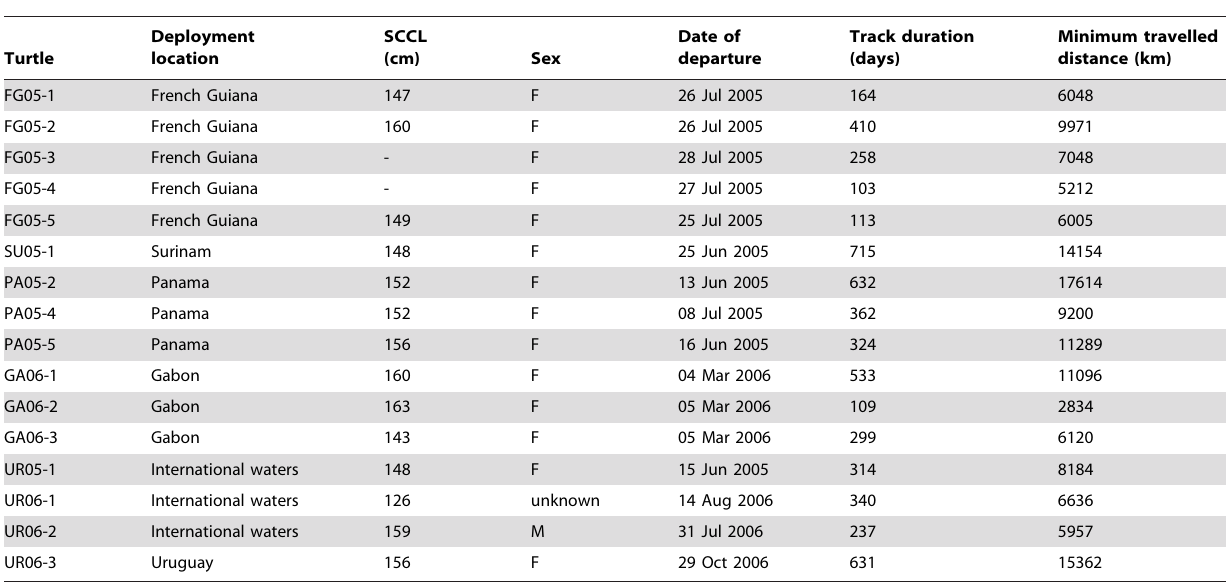
Table 1. Summary of the movements of 16 Argos tracked leatherback turtles during their migration between 2005 and 2008.